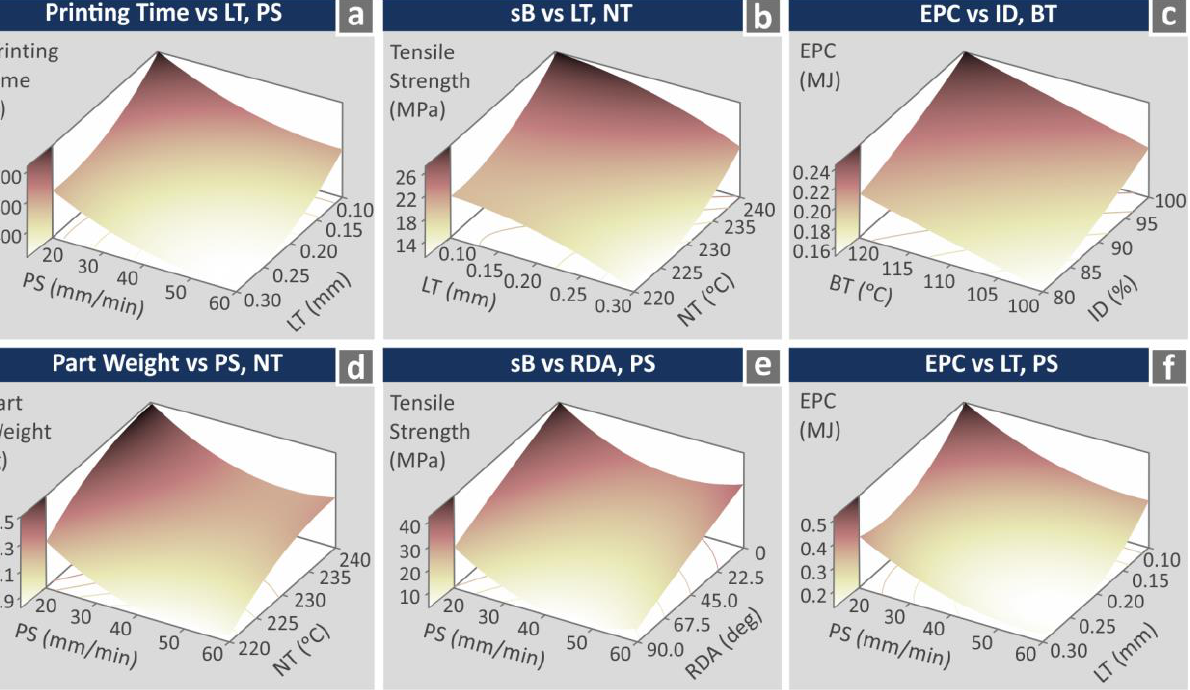
Figure 13. Three-dimensional surface graphs vs. the highest ranked control parameters for the response indicators: ( a ) printing time (s) vs. LT, PS, ( b ) tensile strength (MPa) vs. LT, NT, ( c ) EPC (MJ)